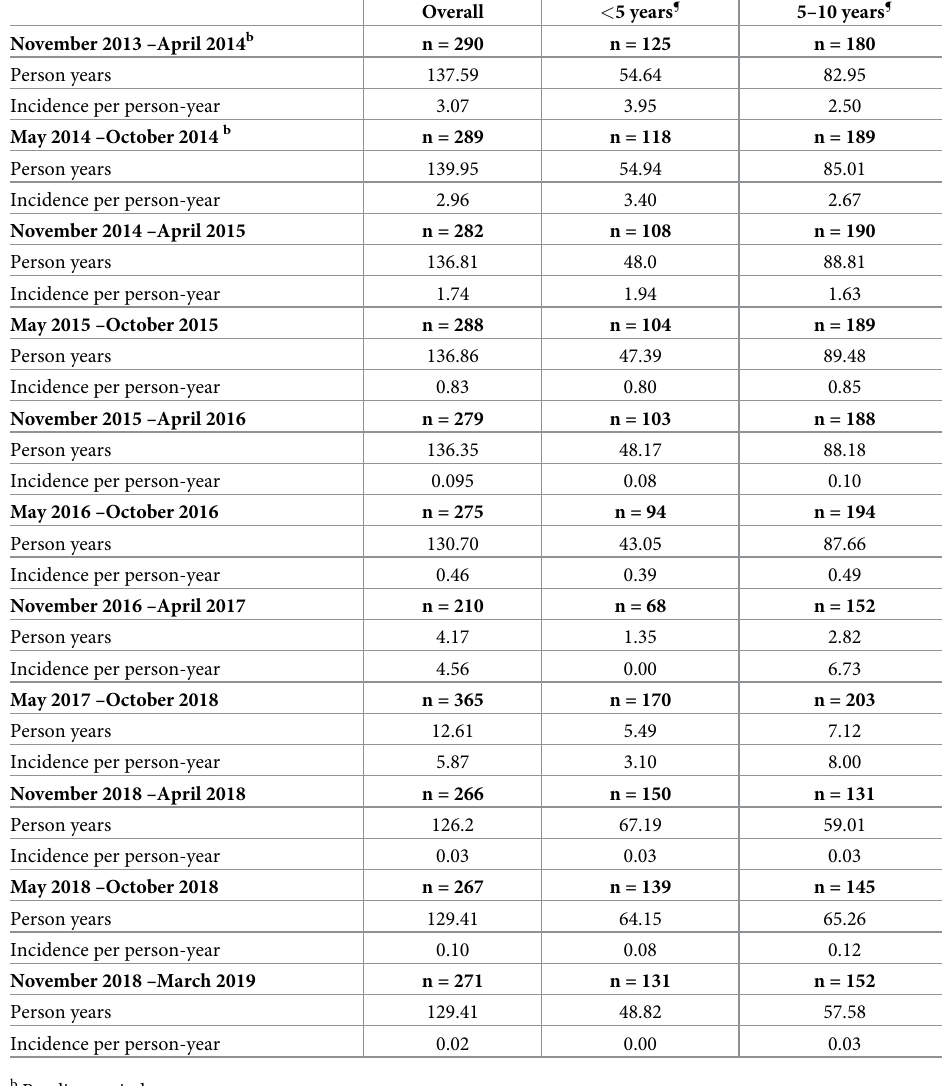
Table 1. Number at risk and six-months period malaria incidence comparing baseline and post IRS